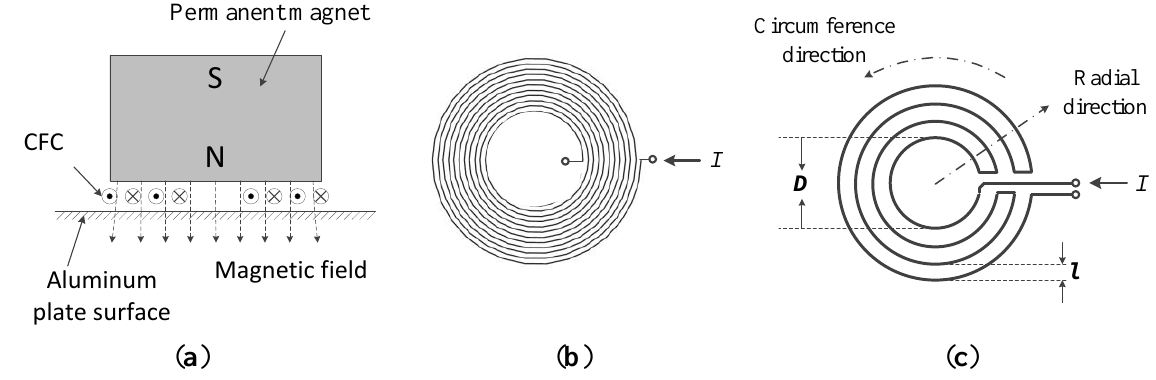
Figure 3. The structure and schematic diagrams of the omni-directional EMATs: ( a ) the structure of the new EMAT; ( b ) the traditional CWSC; and ( c ) the new